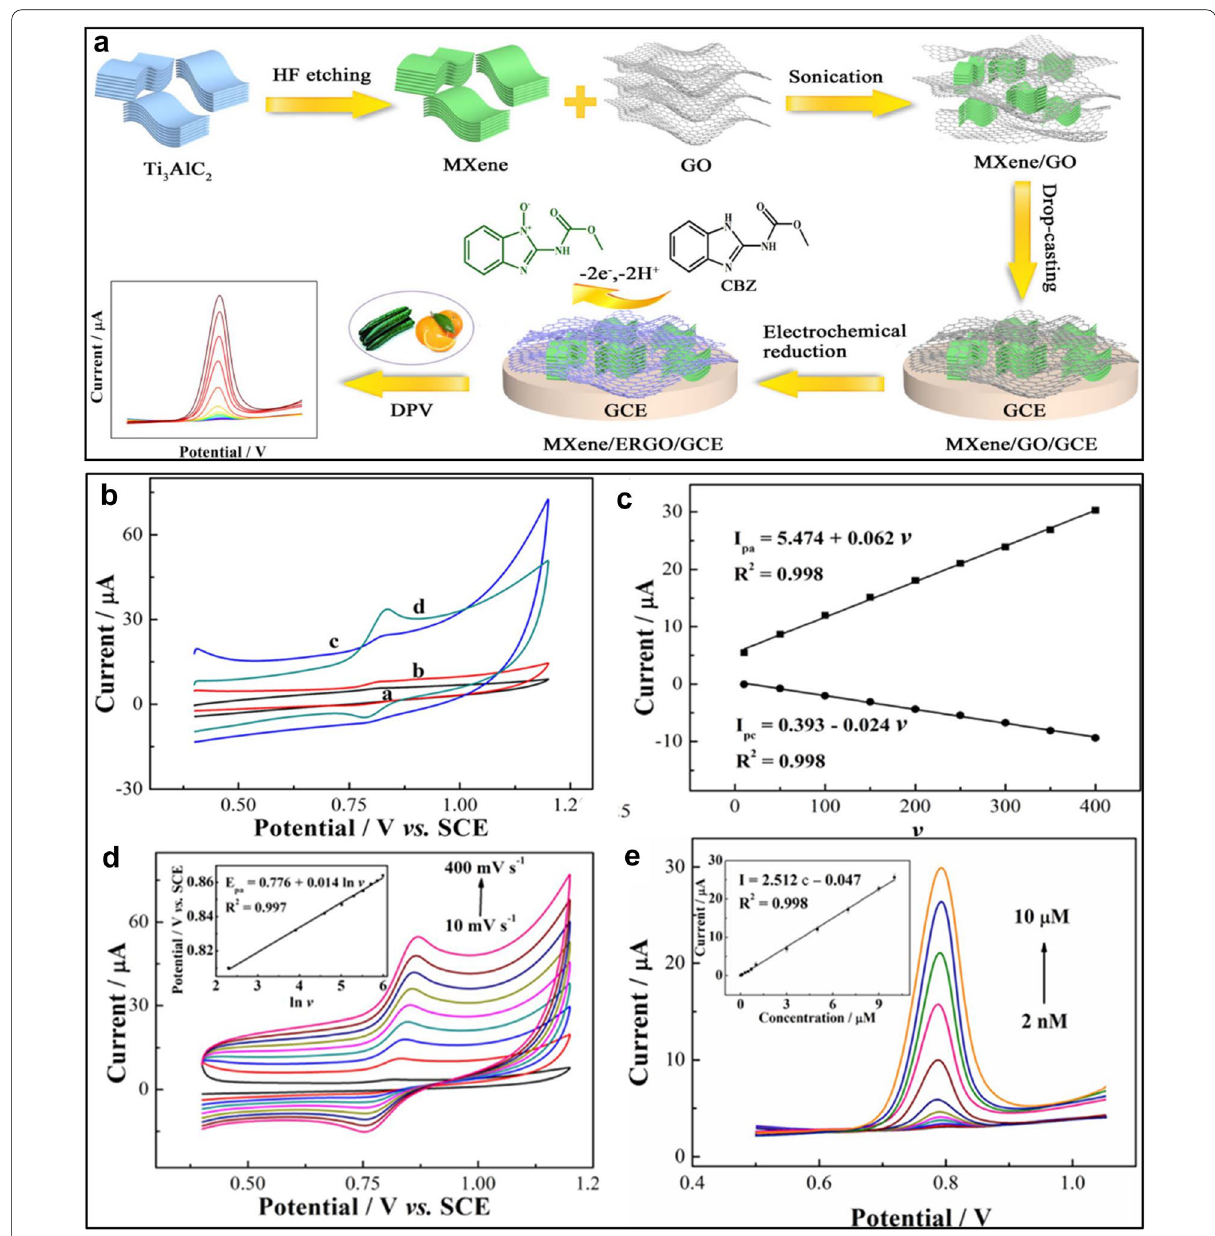
Fig. 8 a Schematic illustration showing the preparation steps for MXene/rGO composite and its deposition on GCE for electrocatalytic sensing of CBZ drug. b CV profiles of the composite with CBZ (5.0 μM) in 0.1 M phosphate buffered Saline (PBS) (pH 7.0) in reference to bare GCE and other compositional competitors; c the corresponding relationship of peak current and natural log of scan rate d The variation of CV scans with different scan rate in the range of 10 to 400 mVs − 1 and. e DPV plots for CBZ at concentrations of 0.002, 0.007, 0.05, 0.07, 0.1, 0.3, 0.5, 0.7, 1.0, 3.0, 5.0, 7.0, 9.0 and 10.0 μM, respectively, with inset showing the corresponding linear fit calibration. Reprint with permission [85]. Copyright 2019